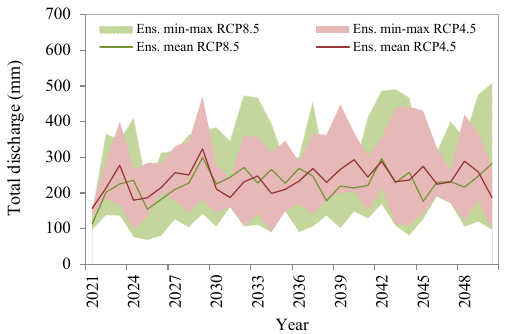
Figure 8. Projected annual discharge for the climate models’ en- semble. Simulations are performed with bias corrected precipitation data.